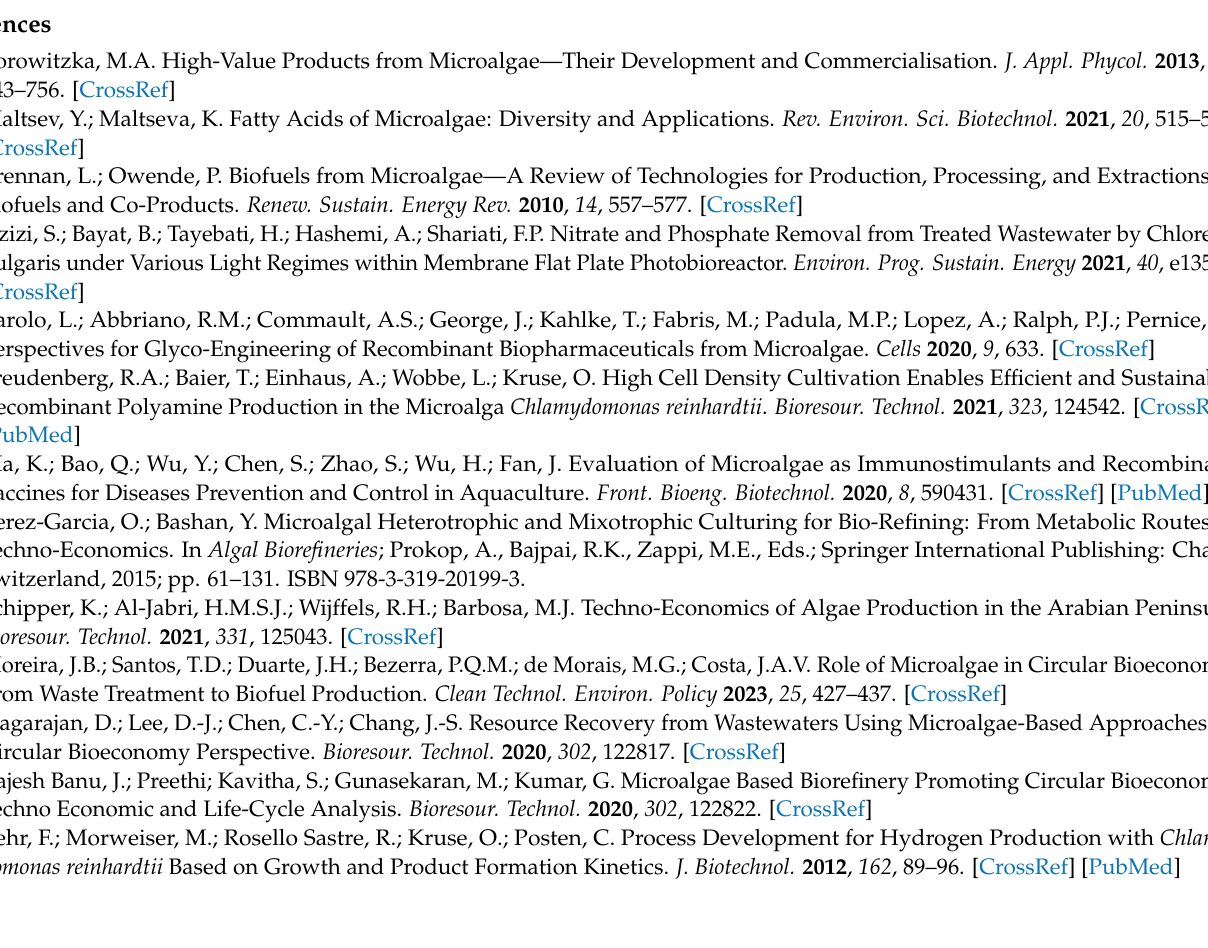
Figure A7. Controller unit with tactile buttons, ON/OFF switch, OLED display, power supply, and power output. Buttons are used for switching between the modes (Button M: start, constant, and day/night) and the LED rows (Button #: Row 1 and Row 2). The other two buttons are counters for fast and precise adjustment of the light intensity. The first counter increases intensity in 10% steps (Button T). The second increases intensity in 1% steps (Button O).